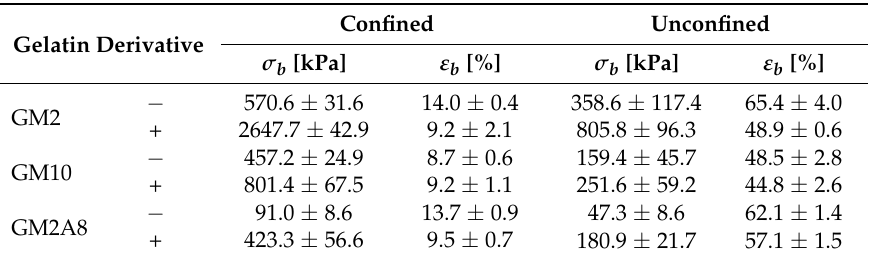
Figure 3. Compressive strains at break ( ε b ) measured in the confined ( A ) or unconfined ( B ) set-up and the respective compressive stresses at break ( σ b ) ( C , D ). Hydrogels were prepared with (+) or without ( − ) cooling. The 25th and 75th percentiles of all specimen determine the boxes. The whiskers mark the inner fence (1.5-fold interquartile range). Data points beyond the inner fence are outliers and shown as black diamonds. The line in the box represents the median and the center of the square the mean. Significant differences are marked as follows: ** p < 0.01, *** p < 0.001. Table 1. Compressive strain at break ( ε b ) and the respective compressive stresses at break ( σ b ) of GM(A) hydrogels measured in a confined or an unconfined setting. Each GM(A) hydrogel was investigated without cooling ( − ) and with cooling (+) before chemical